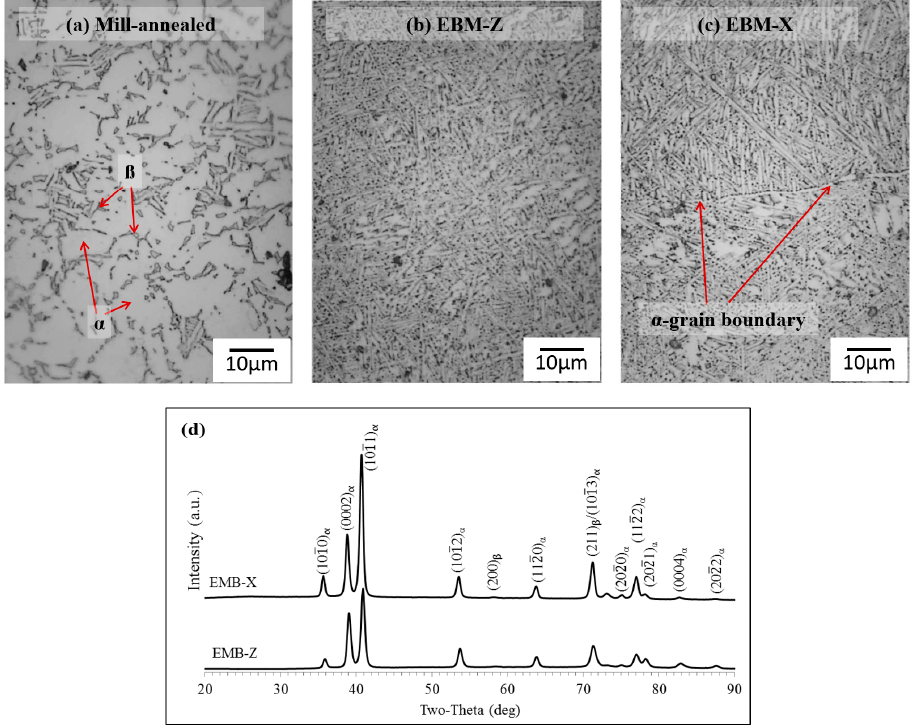
Figure 4. Microstructures of ( a ) Mill-annealed, ( b ) EBM-Z, and ( c ) EBM-X, and ( d ) X-ray diffraction patterns for EBM-Z and -X samples.